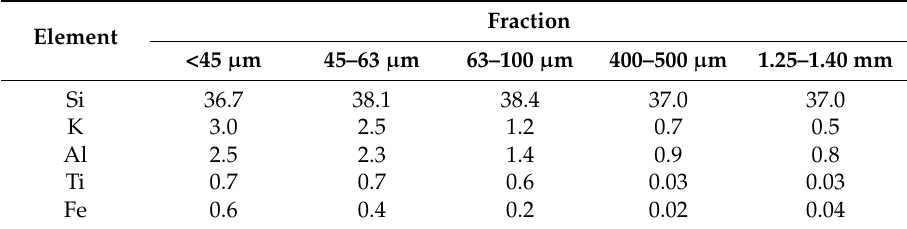
Table 2. Main chemical components of the different quartz fractions as percentages in proportion of